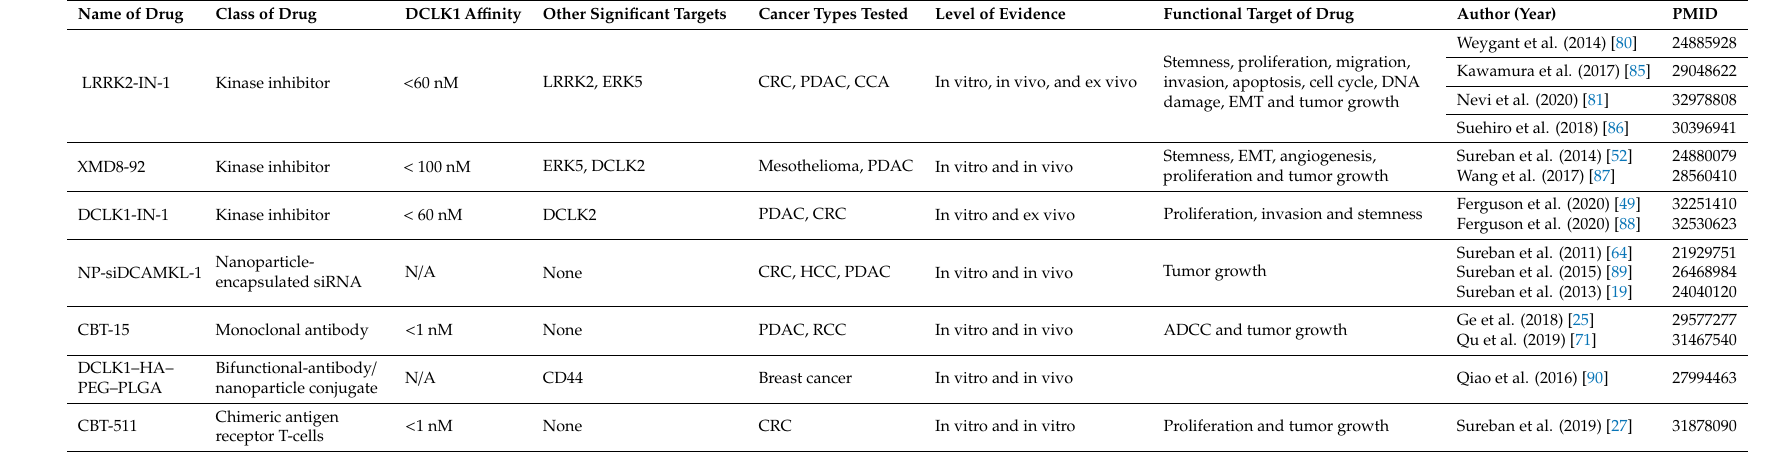
Table 1. Investigational targeted therapies against doublecortin-like kinase